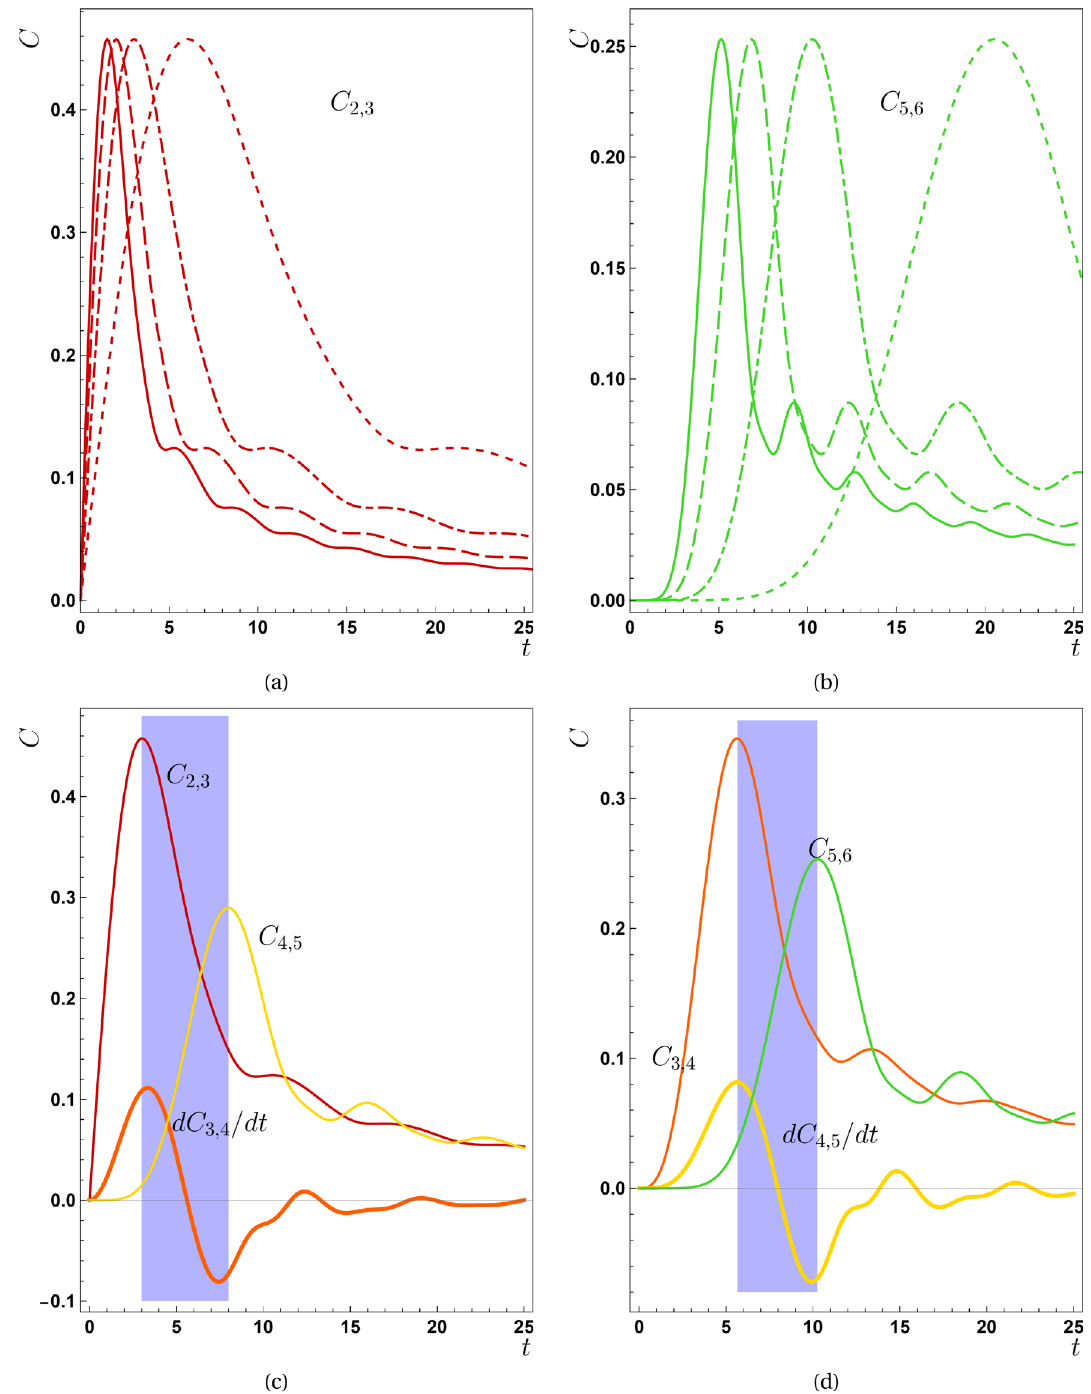
Figure 7. The concurrence-time function for an individual pair ( a ) (2, 3) and ( b ) (5, 6). In fact these plots shows the dependency of maximum entanglement on J values shared in discrete pairs. In both of plots dotted 0.25 , dotdash lines addresses J 0.5 , dashed lines matches to J 0.75 and lines corresponds to J = − = − = − 1.0 . The maximum entanglement for all J values is the same for pairs finally solid lines is associated with J = − (2, 3) in panel ( a ). This rule also holds true for pair (5, 6) in panel ( b ). This phenomenon is generalizable for ∂ C m , m 1 ) for pair of (3, 4) and ( d ) for pair of (5, 6). They are other pairs. ( c ) The time derivative of concurrence ( + ∂ t representative other pairs and mimic their